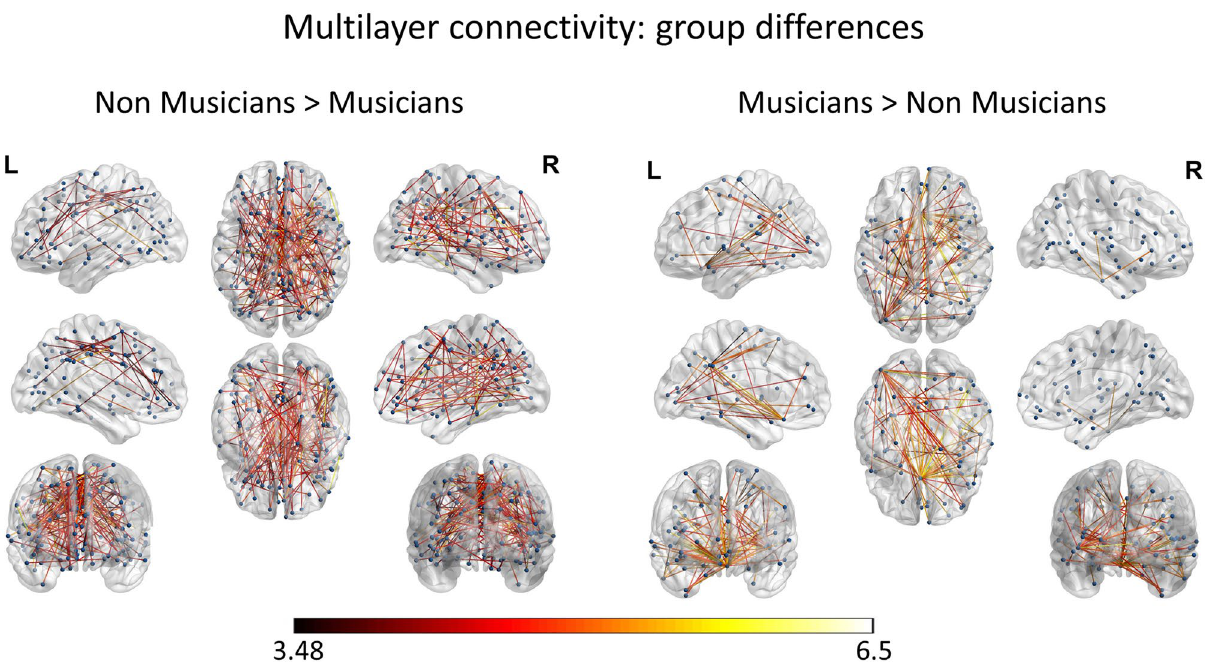
Figure 6. Between groups differences in multilayer connectivity. Statistical parametric maps of the significant networks for the contrast of Non-musicians > Musicians and Musicians > Non-musicians. The color scale indicates t-values, while node strength is represented by node size. Networks presented are significant at p < 0.001, FDR corrected, using 10.000 permutations.